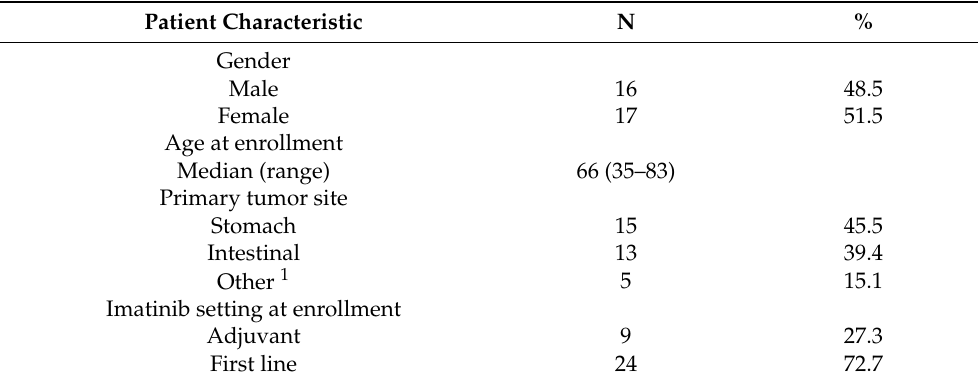
Table 1. Demographic and clinical characteristics of 33 GIST patients included in the CRO-Aviano